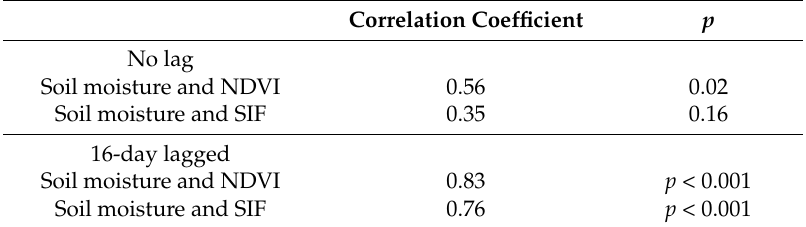
Figure 11. Zonally averaged SIF and NDVI response to soil moisture in East Africa (a black box in Figure 1. This figure was generated from 16-day average SIF from Global Ozone Monitoring Experiment-2 (GOME-2) data (red), NDVI from moderate resolution imaging spectrometer (MODIS) data (dark green), and daily soil moisture (blue) data. Table 1. The relationship between soil moisture and NDVI or SIF from Figure 11. Lagged correlation is calculated as NDVI or SIF is 16 days lagging soil moisture.